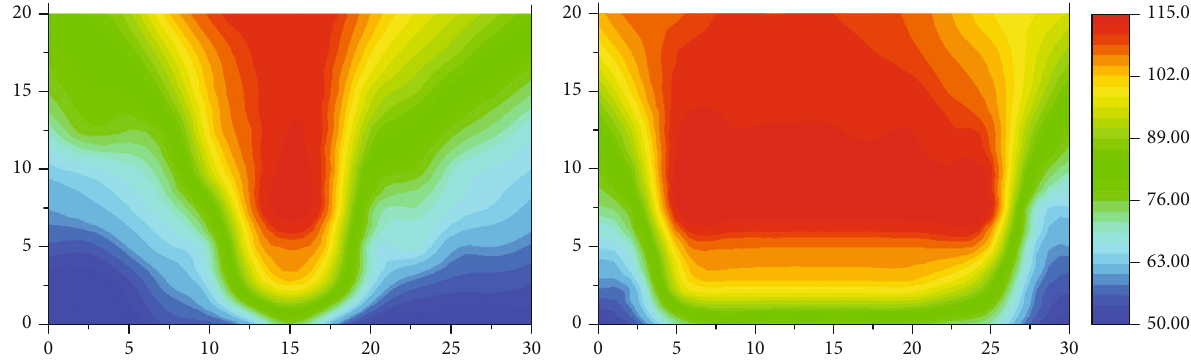
Figure 11: Temperature fi eld in the 3D model during the end stage of Experiment 2: (a) in the vertical direction of the wells and (b) along the